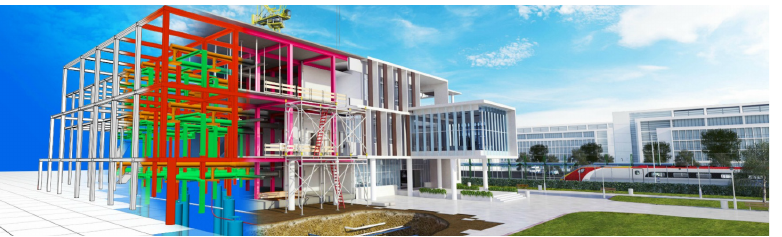
Figure 2. A BIM model of a building (source: https://bim-level2.org/en/, accessed on 29 July 2019).